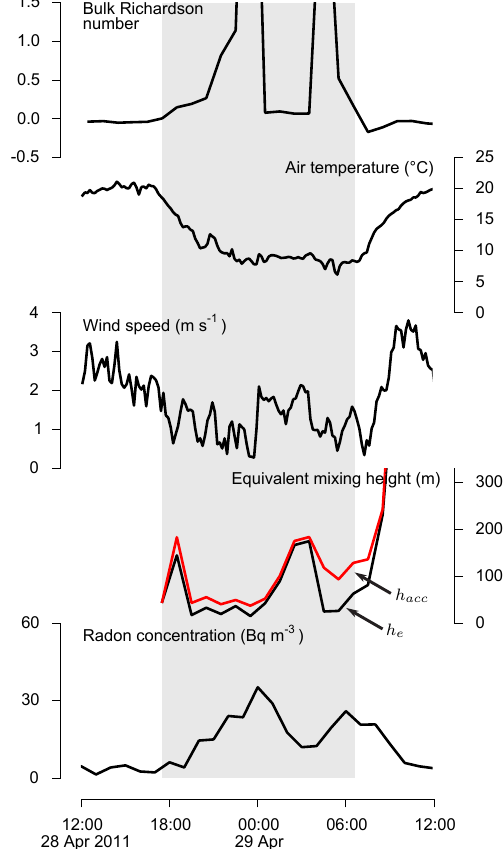
Fig. 7. Case study of a mixing event during a strongly stable night. The bulk Richardson number is computed from 2 and 7.5m wind speed and air temperature, air temperature and wind speed are shown at 2m, the equivalent mixing height is shown as an hour- by-hour computation ( h e ) as well as accumulation since nightfall ( h acc ), and radon concentration is also measured at 2m.